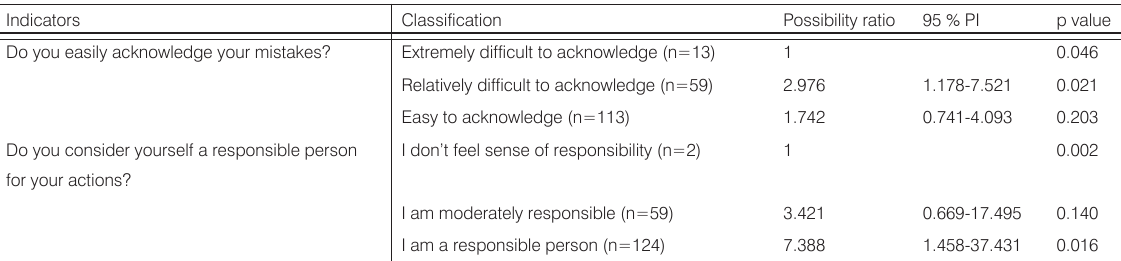
Table 3. Causality between inmates’ physical activity and their social skills